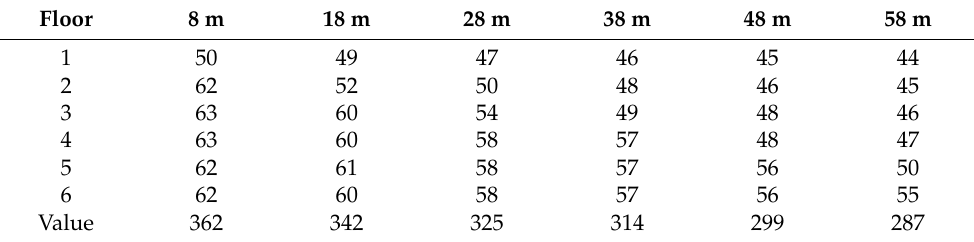
Table 9. Numerical changes of SPL for each layer after adding sound barriers under different setback conditions (Unit: